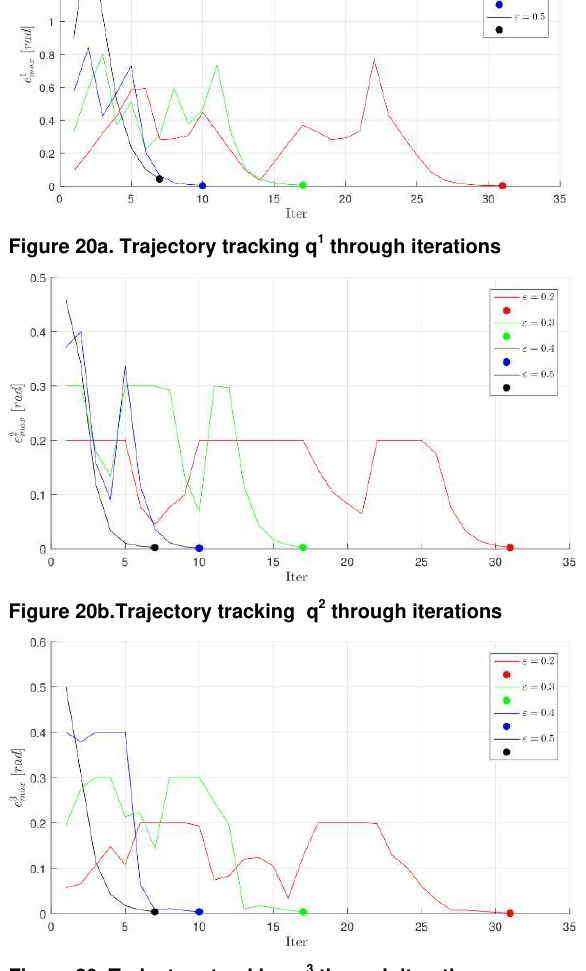
Figure 20. Trajectory tracking q 3 through